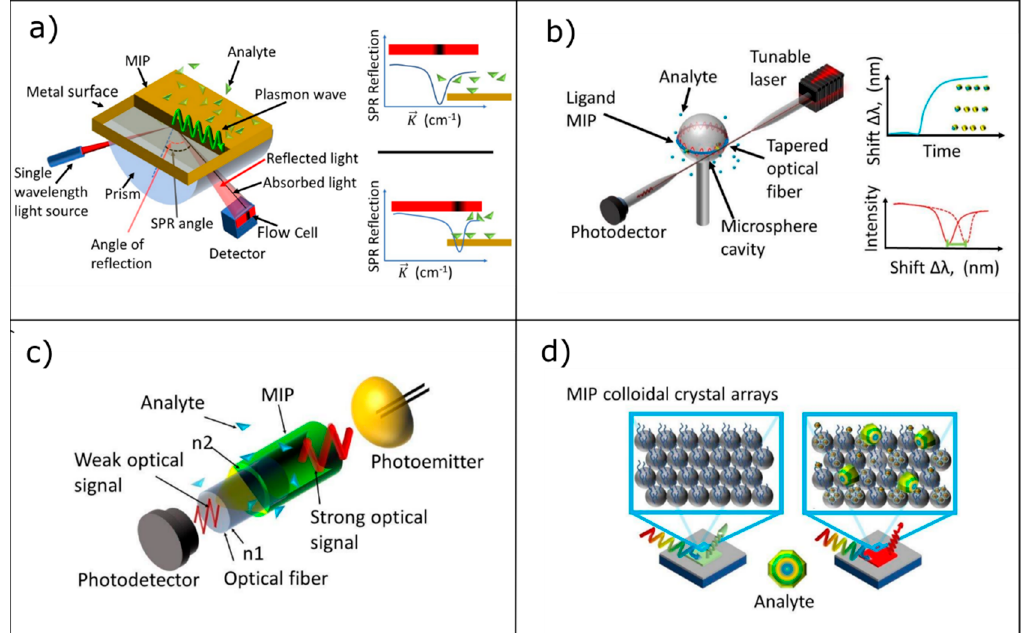
Figure 2. ( a ) Scheme of the surface plasmon resonance (SPR) biosensor where a shift in the surface plasmon (SP) resonance is reported after analyte immobilization, adapted from [45]. ( b ) Sketch of the whispering gallery mode (WGM) biosensor working principle where a resonance shift associated with molecular binding is observed, adapted from [46]. ( c ) Concept of the Optical Waveguide Lightmode Spectroscopy approach based on evanescent wave for biomolecules detection through optical fiber or waveguide taking advantage of different refractive indexes (n1 and n2), adapted from [47]. ( d ) Chromatic sensor exploiting colloidal crystals properties, capable of detecting analytes by observing color changes in the dry condition, adapted from [48].